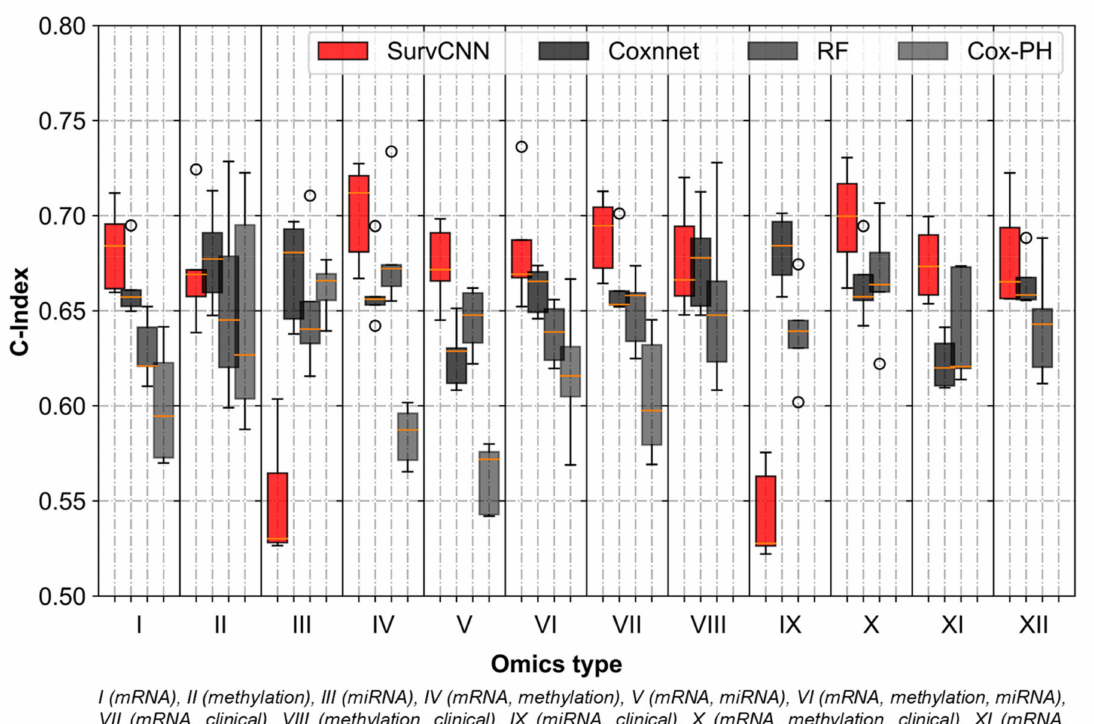
Figure 4. Comparison of performance measure (C-index) with existing methods. The effectiveness of SurvCNN’s novel feature transformation approach is highlighted with the fact that it outperforms the competition in nine out of twelve omics sets